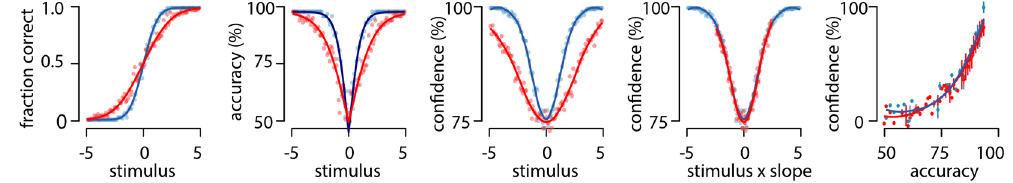
Figure 4. Simulated results from an ideal observer model. Modelled with greater perceptual noise in touch ( σ = 2) than in vision ( σ = 1), the observer shows a shallower psychometric function for touch ( a , b ), and as a result, confidence for touch is usually below that for vision, for a given stimulus ( c ). Unlike observers, however, this ideal observer is equally confident (75%) in both modalities for stimuli at PSE ( c ), and for each stimulus, average confidence tracks average accuracy in the same way across modalities ( d ). Therefore, differences in sensitivity between the modalities alone cannot explain our